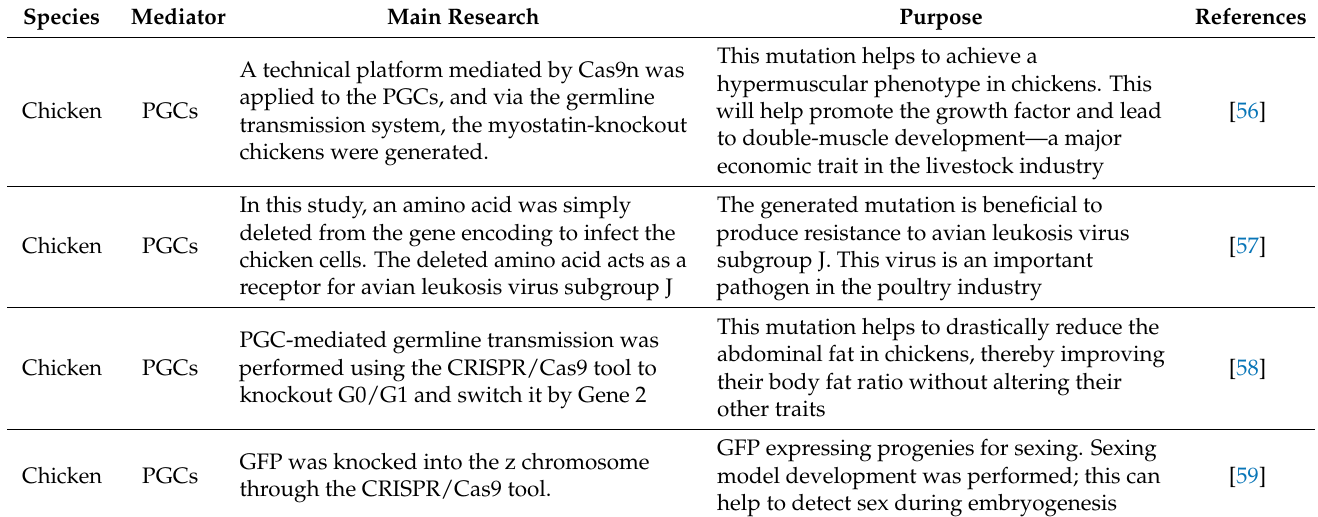
Table 2. The most recent chicken genome-editing studies using